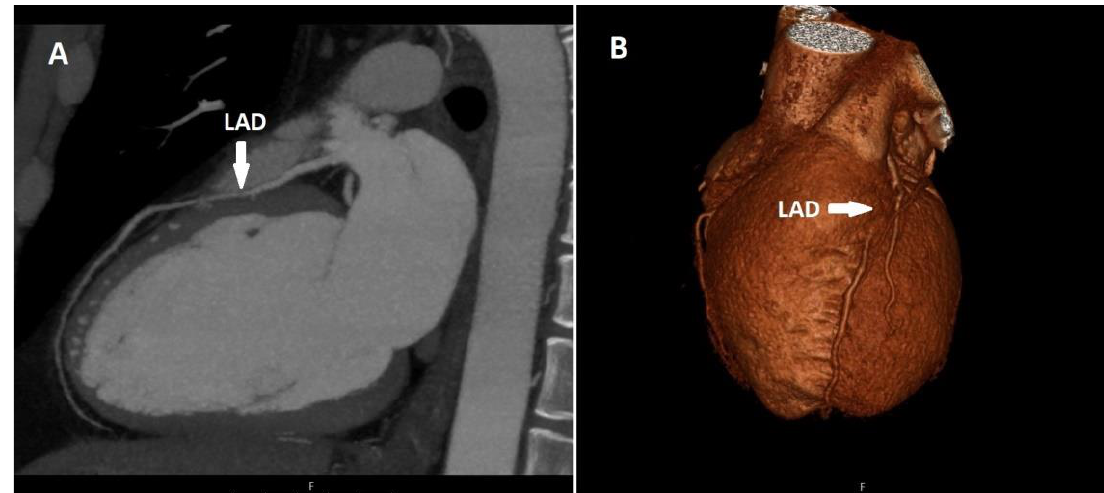
Figure 3. Sagittal CT maximum-intensity projection (MIP) ( A ) and volume-rendered (VR) ( B ) image shows myocardial bridging in the proximal segment of the LAD. Of the two patients with myocardial bridging only in the LAD, one had a fusiform aneurysm in the LAD and the other in the LCX. There were 40 patients (29.4%) with artery duplications, and all were LAD duplications (Figure 4).